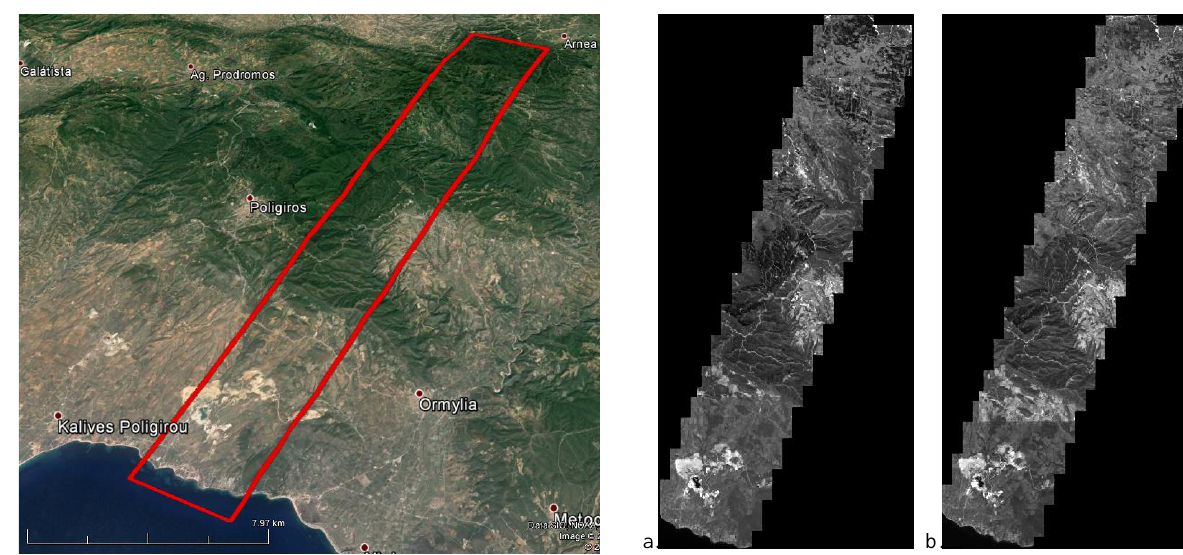
Figure 4.The Geoeye-1 PAN stereo pairs (0.5m).